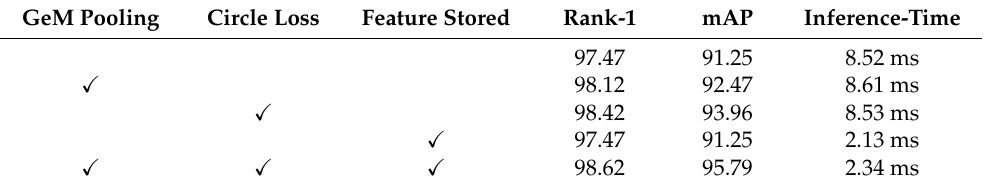
Table 4. The ablation